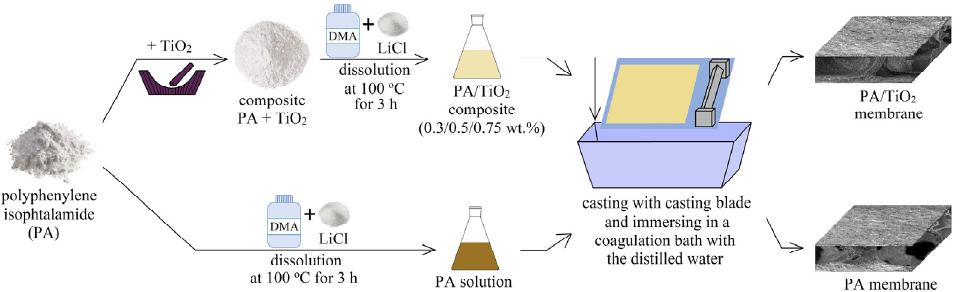
Figure 2. The scheme of preparation of porous membranes based on PA and its composites with TiO 2 .